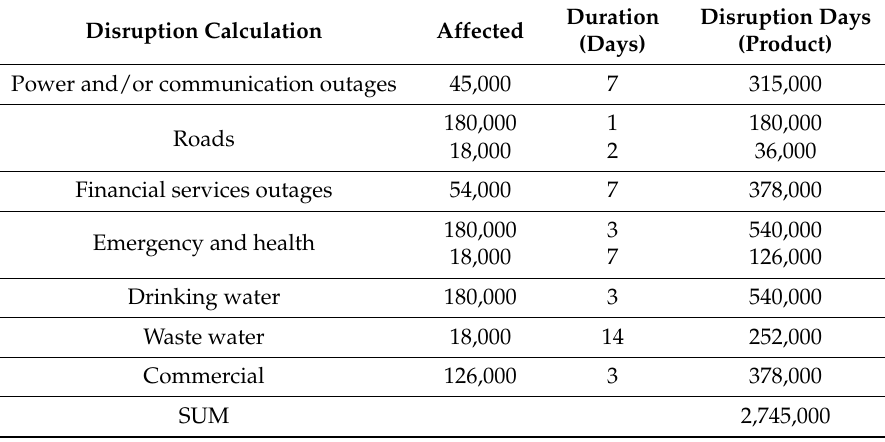
Table 2. Disruption days calculation: affected persons times